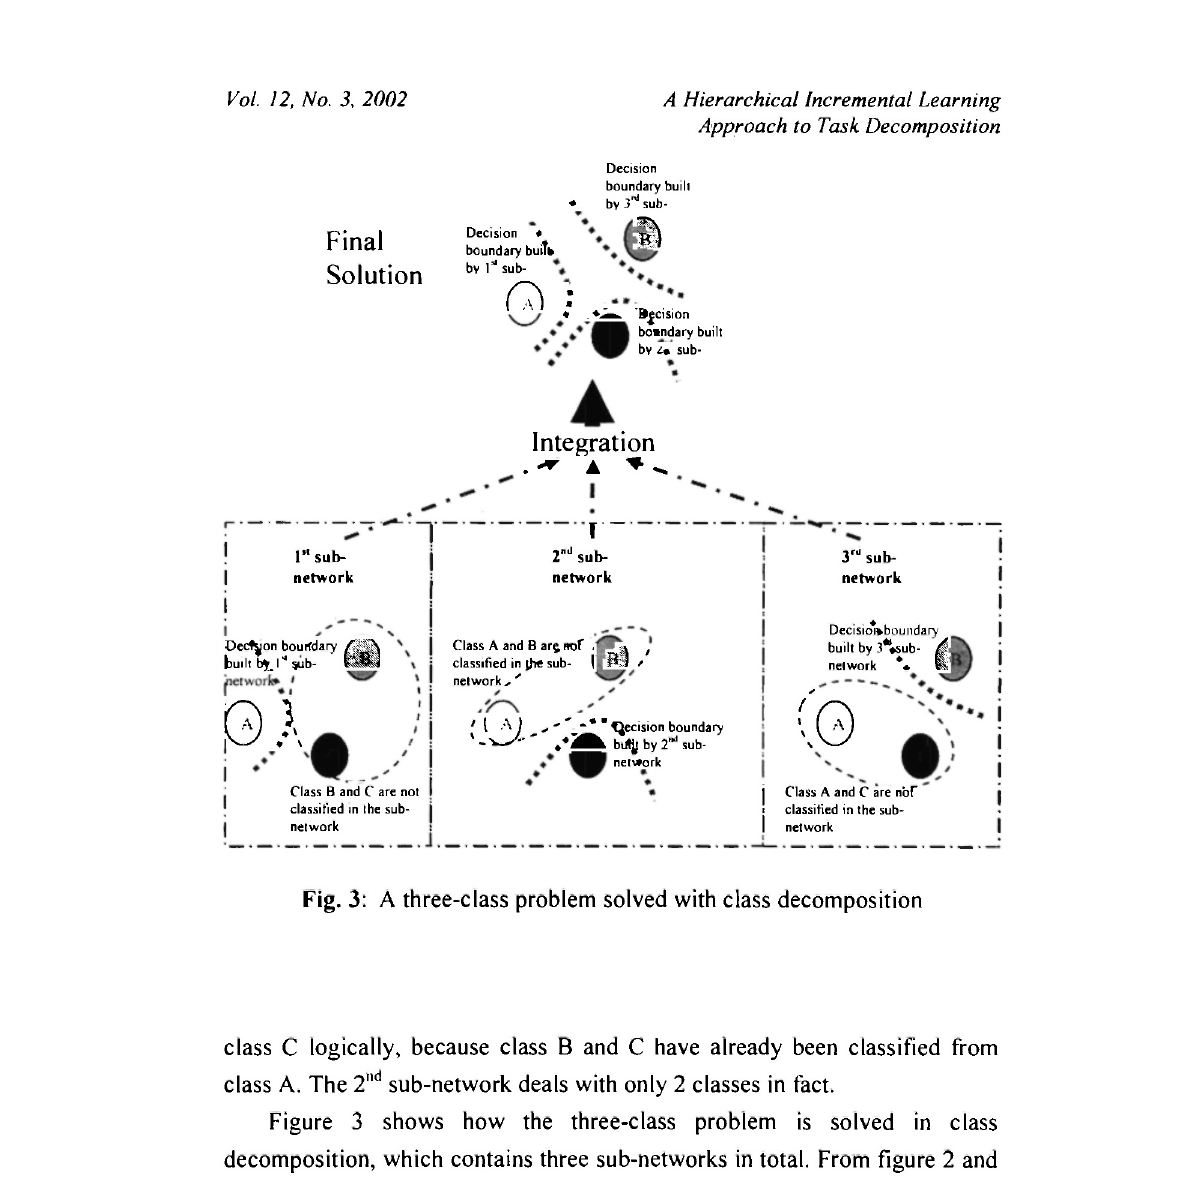
class C logically, because class Β and C have already been classified from class A. The 2 nd sub-network deals with only 2 classes in